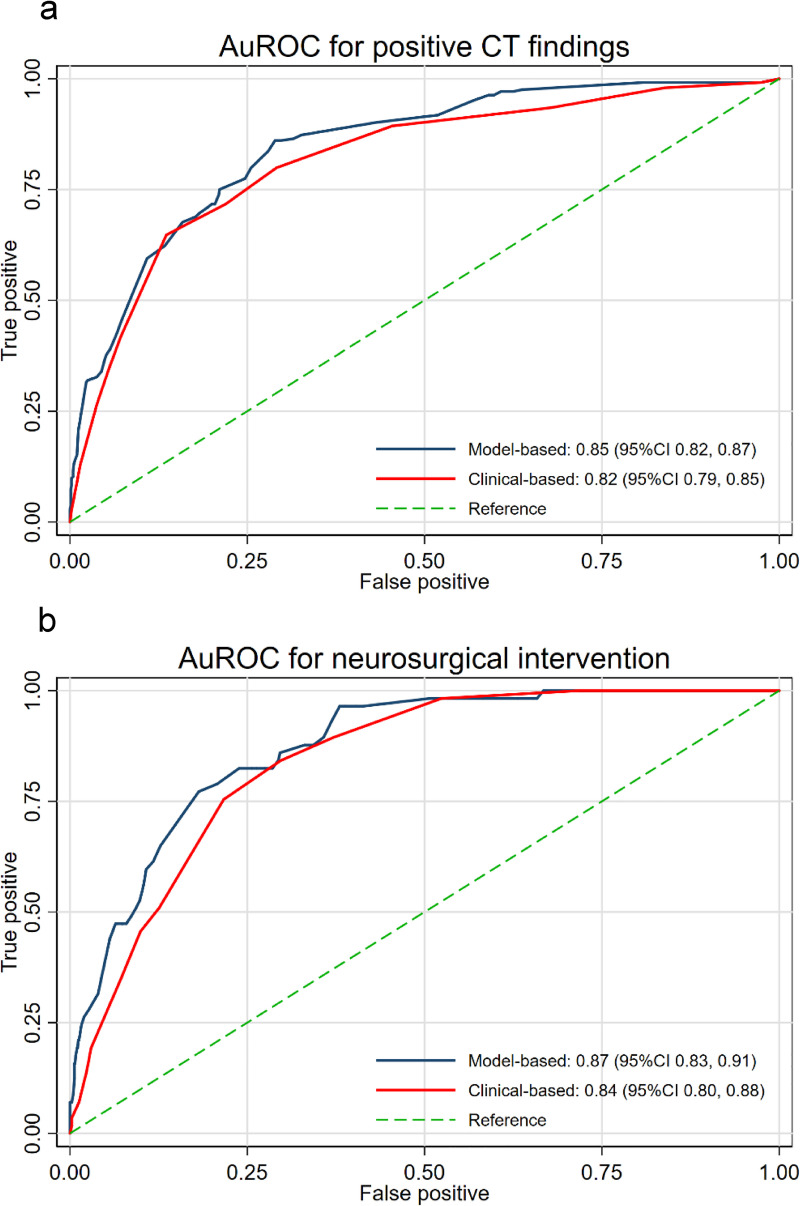
Comparison of discriminative ability between the model-based scoring system and the clinical-based scoring system in distinguishing the presence of positive CT findings (2a) and the requirement of neurosurgical intervention within seven days (2b). Abbreviations: AuROC, area under receiver operating characteristic curve; CT, computed tomography; CI, confidence interval.